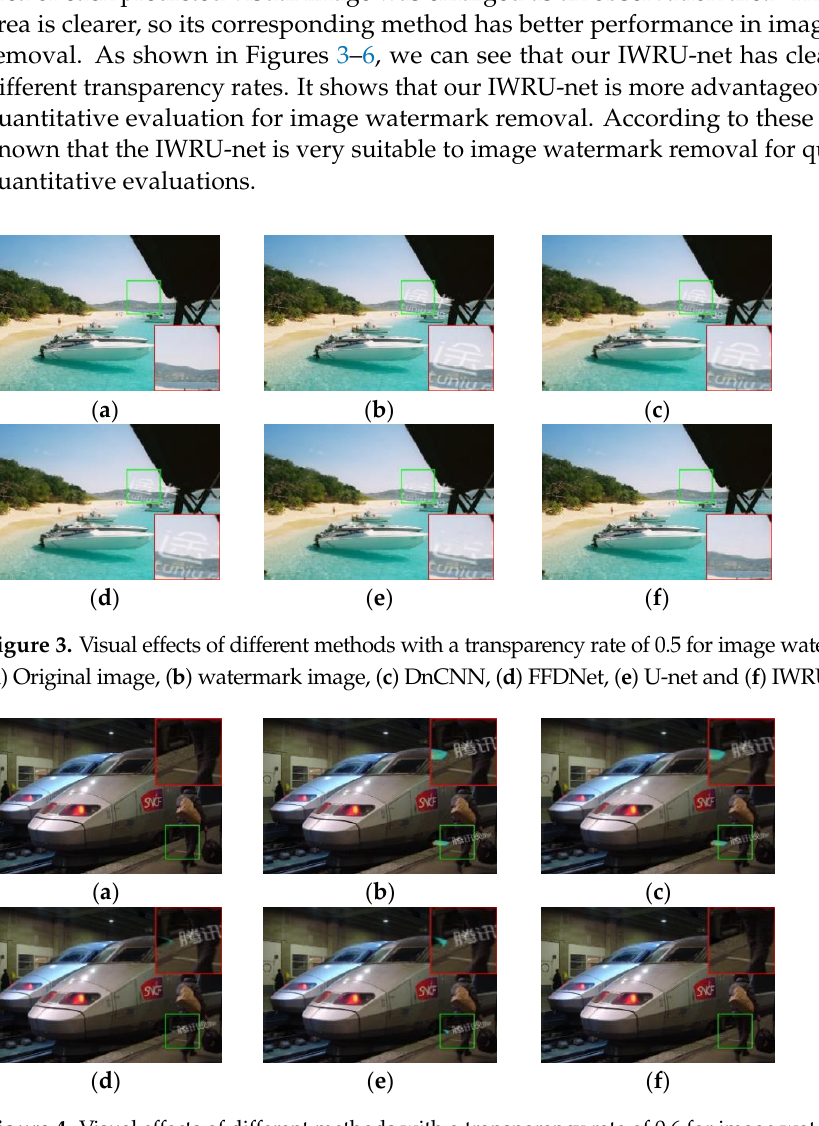
( f ) Figure 5. Visual effects of different methods with a transparency rate of 0.7 for image watermark removal. ( a ) Original image, ( b ) watermark image, ( c ) DnCNN, ( d ) FFDNet, ( e ) U-net and ( f ) IWRU- net (ours). ( f ) Figure 6. Visual effects of different methods with a transparency rate of 0.8 for image watermark removal. ( a ) Original image, ( b ) watermark image, ( c ) DnCNN, ( d ) FFDNet, ( e ) U-net and ( f ) IWRU- net (ours). 5. Conclusions We propose an improved watermark removal U-net as IWRU-net. To improve the robustness of the obtained information, a serial architecture was used to facilitate more accurate information to guarantee the performance for watermark removal. To address